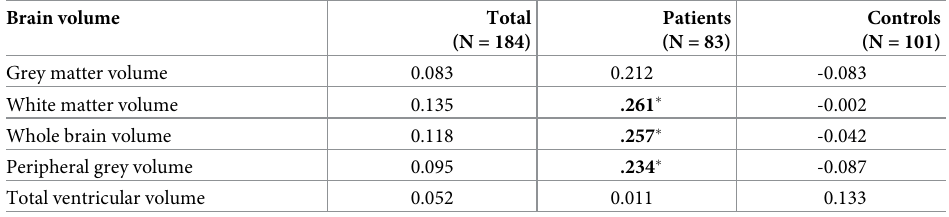
Table 3. Pearson’s correlations for S-25(OH)D and brain volume stratified for patients and healthy controls.